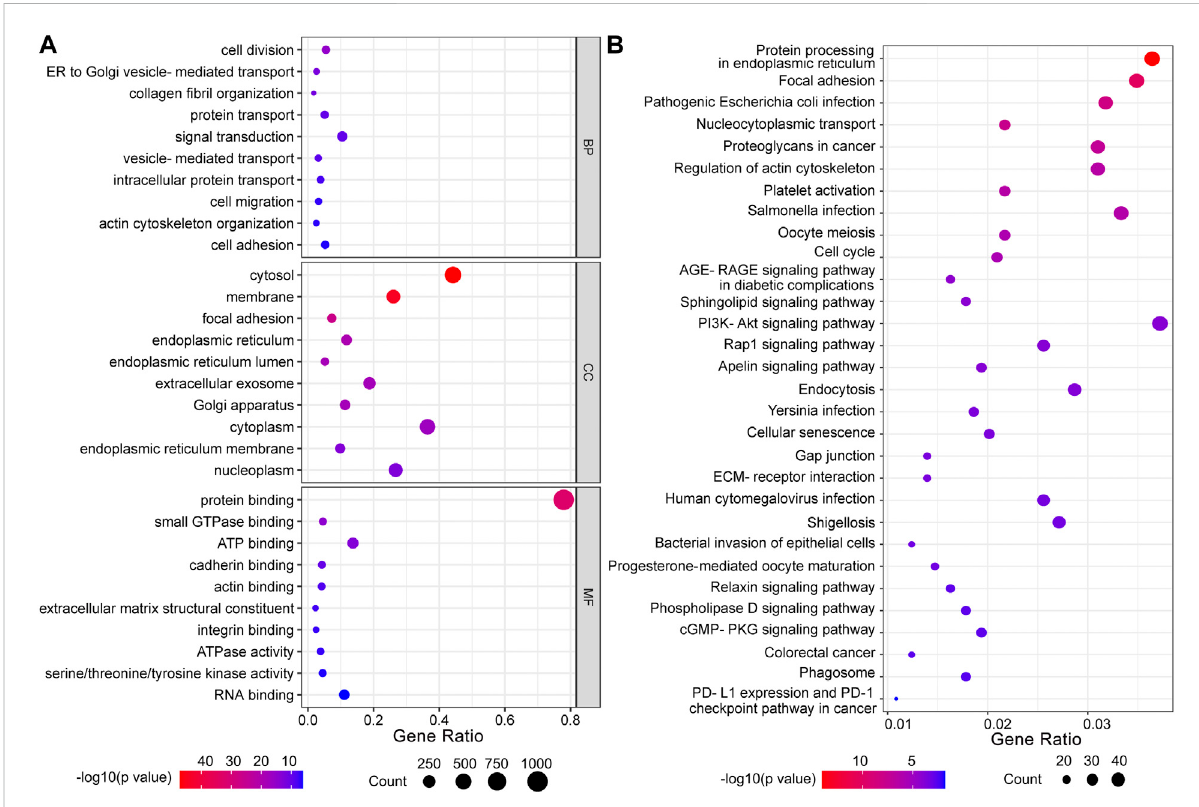
FIGURE 5 Functional enrichment analysis of co-expressed genes with HBP signature. (A) GO function analysis. BP: biological processes; CC: cellular components; MF: molecular function. (B) KEGG pathway